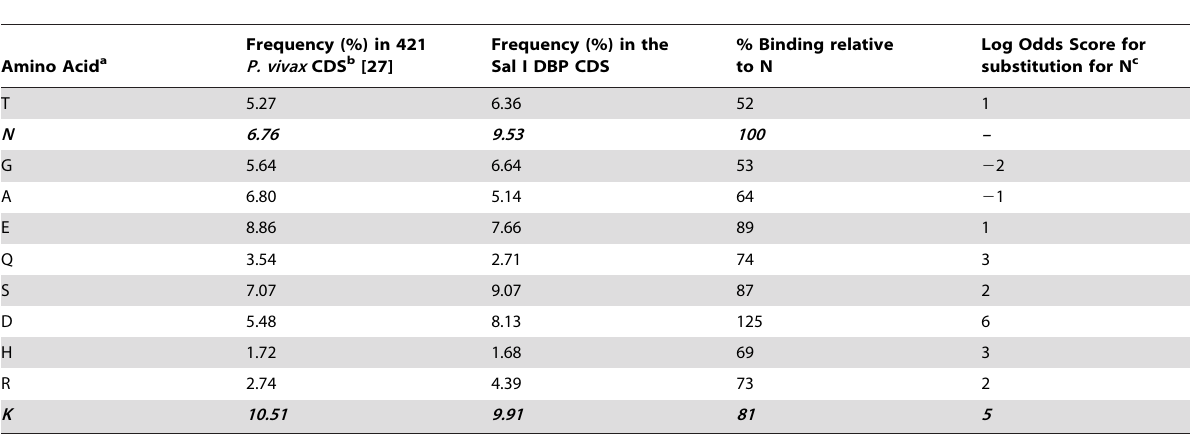
Table 2. Amino acid frequency in 421 P. vivax CDS and Sal I DBP